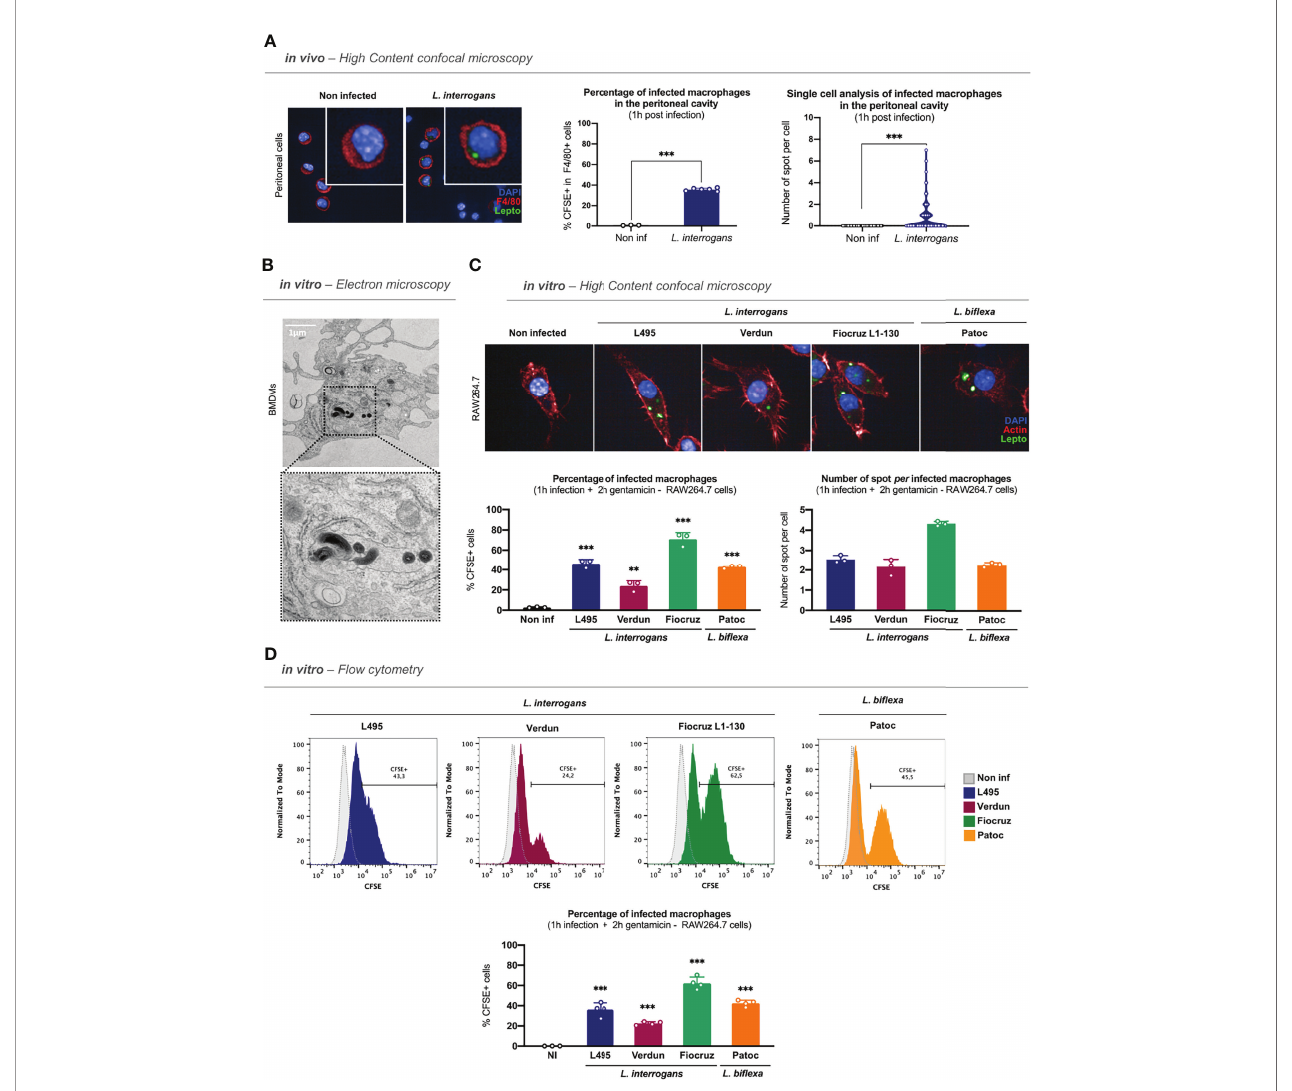
FIGURE 1 | Leptospires are internalized in murine macrophages. (A) High-content (HC) confocal microscopy images and analyses of adherent F4/80 + peritoneal cells 1 h post intra-peritoneal injection of 5 × 10 7 CFSE-labeled L. interrogans serovar Manilae strain L495 in C57BL/6J mice. (B) Electron microscopy images of bone marrow-derived macrophages infected 1 h with MOI 100 of L. interrogans serovar Manilae strain L495. (C) HC confocal microscopy images and analyses of RAW264.7 cells infected 1 h with MOI 100 of CFSE-labeled L. interrogans serovar Manilae strain L495, serovar Copenhageni strain Fiocruz L1 – 130, serovar Icterohaemorrhagiae strain Verdun, and L. bi fl exa serovar Patoc strain Patoc I and after gentamicin protection assay. (D) Flow cytometry histograms and analyses of RAW264.7 cells infected 1 h with MOI 100 of CFSE-labeled L. interrogans serovar Manilae strain L495, serovar Copenhageni strain Fiocruz L1 – 130,